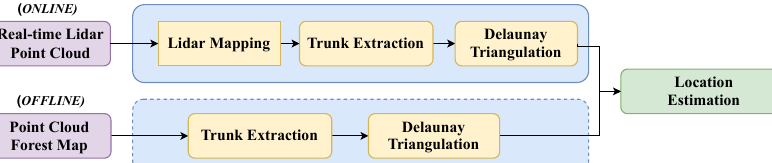
Figure 3. System overview: sensor data is matched with a global map to produce a global position estimation. Consecutive runs are independent.